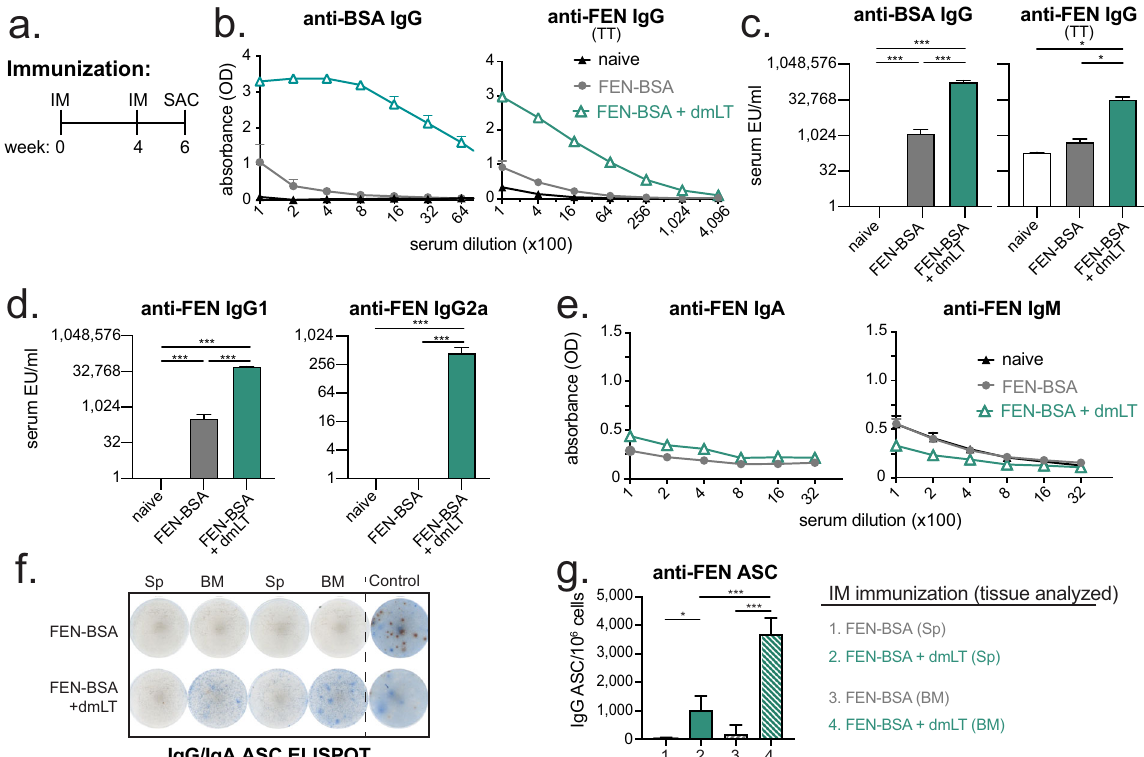
Fig. 1 Immune responses to intramuscular immunization with FEN-BSA are enhanced with dmLT adjuvant. Groups of Balb/c mice ( n = 4) were left naïve or immunized intramuscularly with 8 μ g FEN-BSA ± 1 μ g dmLT on weeks 0 and 4. Two-weeks later (week 6) serum, spleen, or bone-marrow were collected for antibody evaluations. a Schematic of immunization schedule identifying week of immunizations (IM) and sacri fi ce for blood, spleen, and bone-marrow sample collections (SAC). b Raw ELISA data for serum anti-BSA or anti-FEN IgG expressed as 405 nm optical density (OD) absorbance. For anti-FEN IgG, plates were coated with FEN-TT. c Compiled ELISA units (EU)/ml of indicated serum anti-BSA and anti-FEN IgG titers assessed by ELISAs graphed on a log2 scale. d Compiled EU/ml of indicated serum anti-FEN IgG1 or IgG2a. e Raw ELISA data for serum anti-FEN IgA and IgM. f Representative images for ASCs IgG/IgA ELISPOT results using splenocytes (Sp) or bone marrow (BM) cells and plates coated with FEN-TT. Blue spots indicate IgG ASCs and red spots IgA ASCs. g Compiled ASC per 10 6 cells from spleens or bone marrow. Bars at mean + s.e.m. with signi fi cance indicated as (***) for P ≤ 0.001 (*) for P ≤ 0.05 by one-way ANOVA with Bonferroni ’ s multiple comparisons